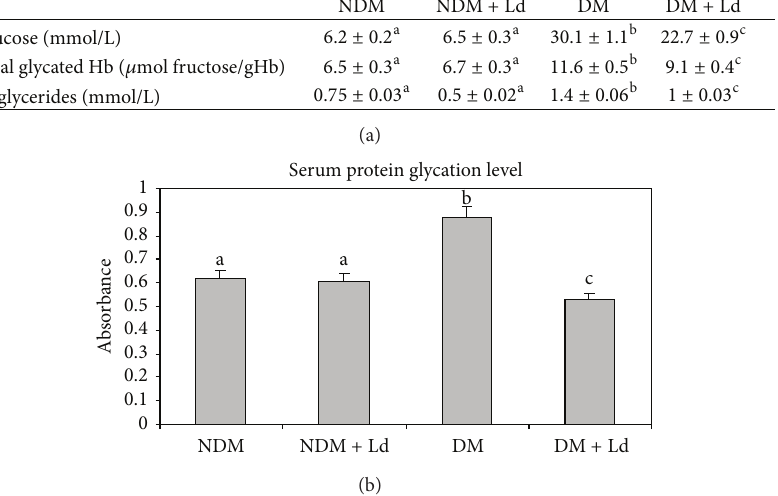
Figure 1: The effect of L. deterrimus extract administration on the biochemical parameters in sera (a) and glycation levels of serum proteins (b). NDM: control rats; NDM + Ld: control rats treated daily with L. deterrimus extract for four weeks; DM: STZ-induced diabetic rats; DM + Ld: STZ-induced diabetic rats treated with L. deterrimus extract for four weeks. Hb: haemoglobin. The values are presented as the mean ± S.E.M.; values not sharing a common superscript letter differ significantly at 𝑃 < 0.05 .